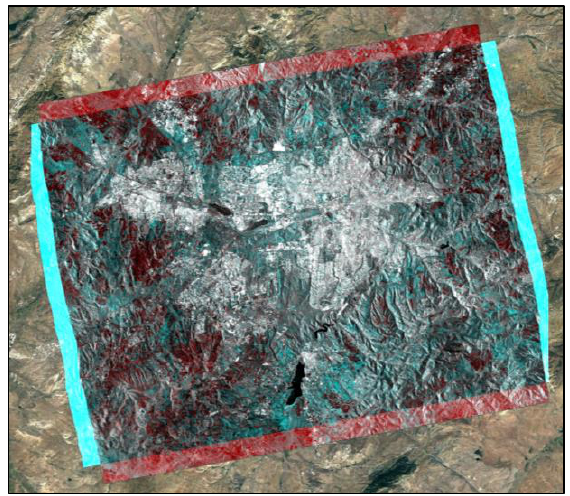
Figure 8. RGB composition of study area.